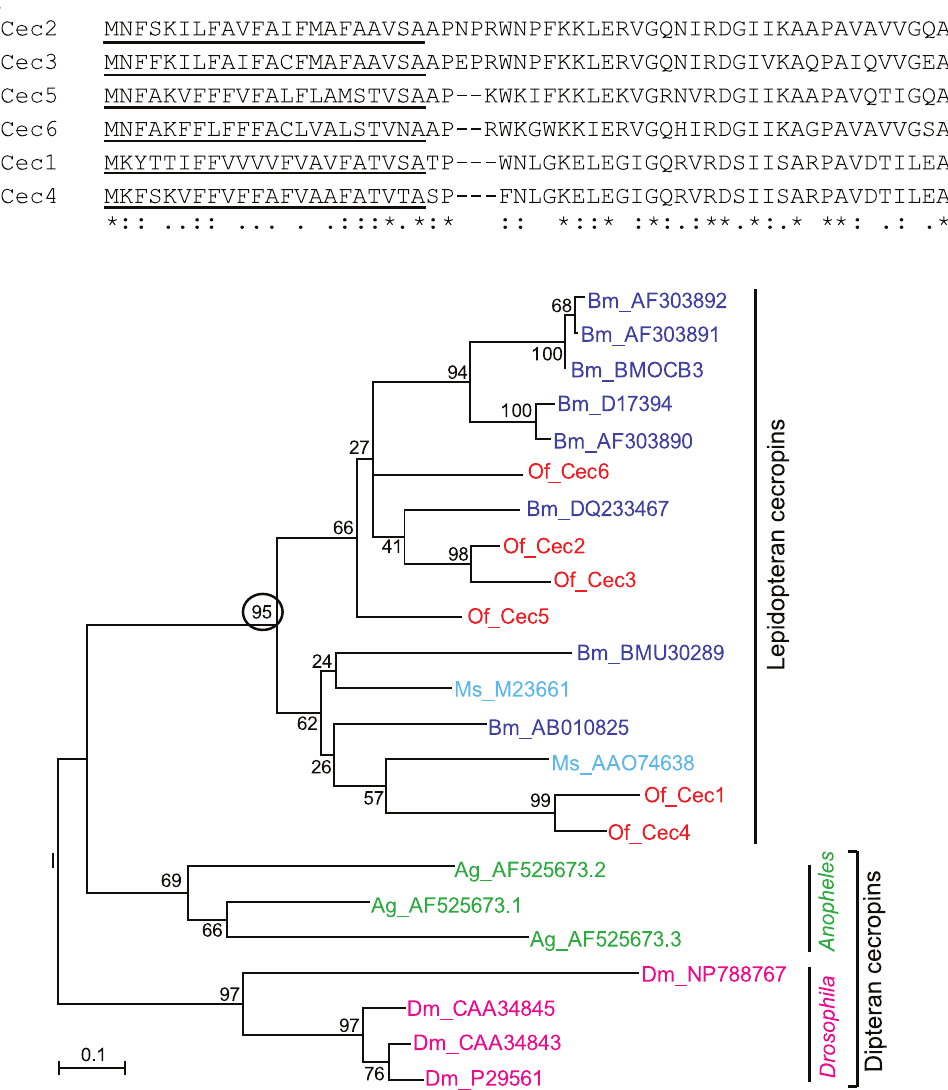
Figure 10. Alignment of full-length O. furncalis cecropins (A) Completely conserved amino acids are indicated by ‘*’, conservative substitutions by ‘:’, and semiconserved substitutions by ‘.’ below the sequences. The predicted secretion signal peptide is underlined. (B) Phylogenetic analysis of cecropins. The amino acid sequences from 8 Ostrinia (Of, red), 4 Drosophila (Dm, pink), 3 Anopheles (Ag, green), 8 Bombyx (Bm, purple), and 2 Manduca (Ms, blue) cecropins were used to build the neighbor-joining tree. Numbers at the nodes are bootstrap values as percentage. Only bootstrap values greater than 70 are shown. The circled bootstrap value indicates that Ostrinia cecropins belong to lepidopteran